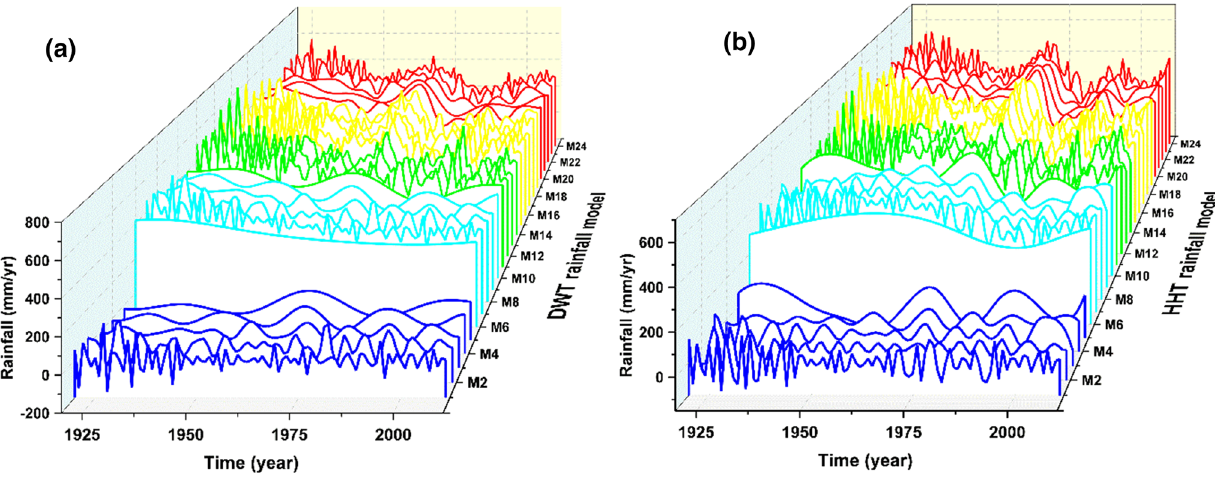
Fig. 4 The 24 proposed models resulting from the a discrete wavelet transform and b Hilbert Huang transform for the Oued Taria